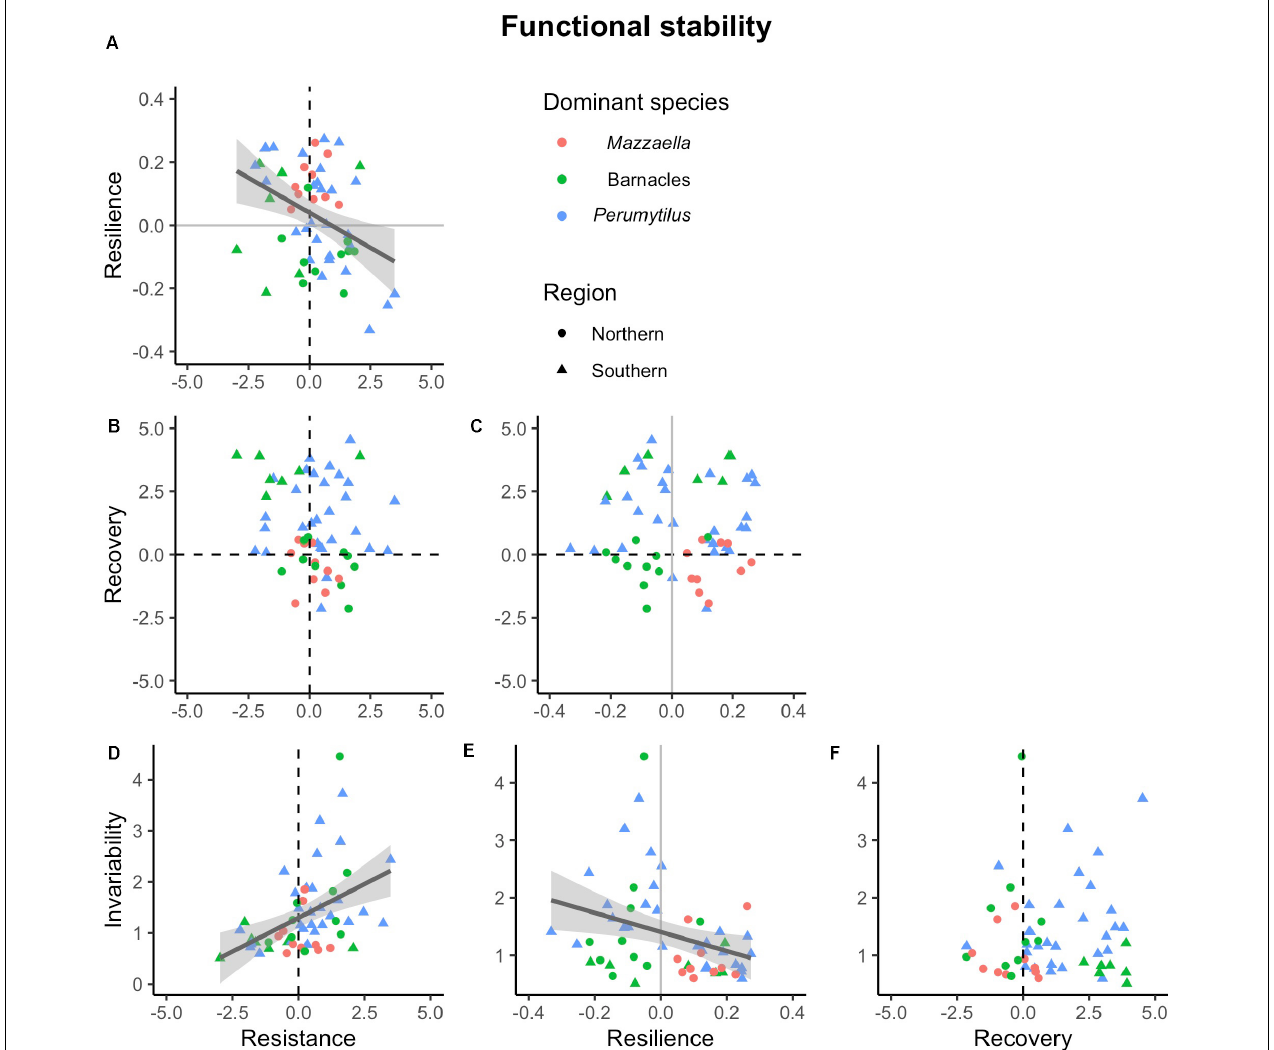
FIGURE 5 | Associations among four dimensions of functional stability. All pairwise combination were analyzed: resilience against (A) resistance; recovery against (B) resistance and (C) resilience; and invariability against (D) resistance, (E) resilience, and (F) recovery. Dashed lines represent reference values for maximum resistance and recovery; solid gray lines represent reference values for minimum resilience. Across communities, statistically significant correlations were detected for the resistance-resilience, resistance-invariability, and resilience-invariability pairs (trend lines ± 95% confidence intervals; r = − 0.38, r = 0.39, and r = − 0.36, respectively; P <